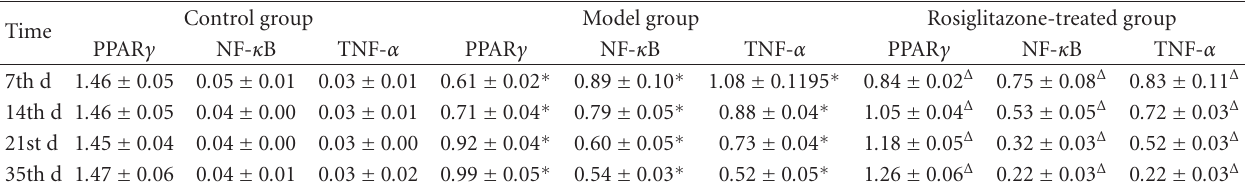
Table 3: Colonic mucosal mRNA expression of PPAR γ , NF- κ B, and TNF- α (mean ±